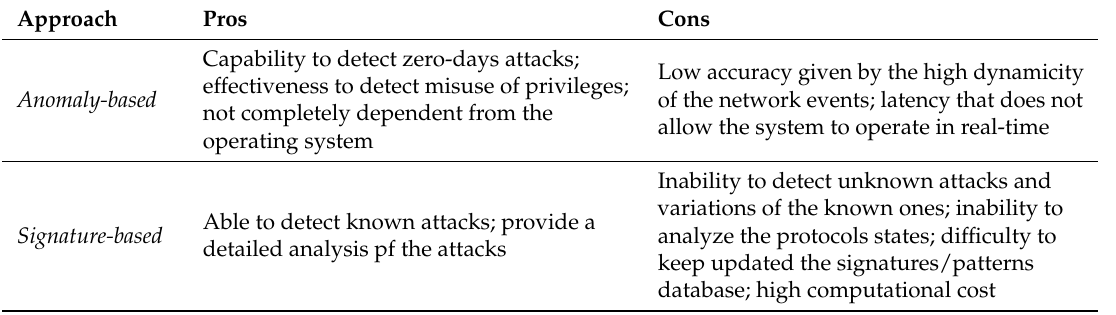
Table 1. Pros and cons of IDS operative